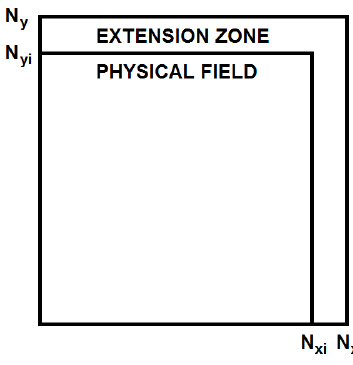
Figure 2. A typical setup of the NWP model domain with the ex- tension